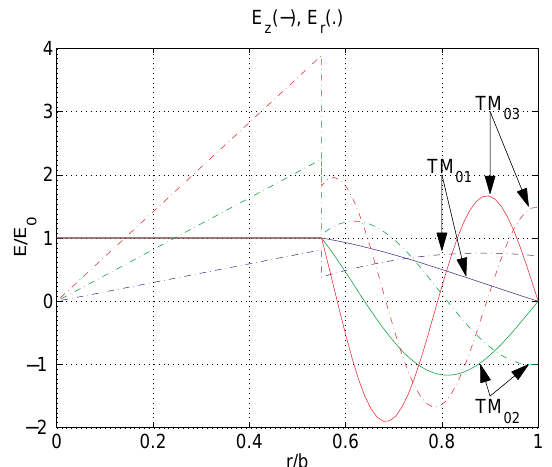
FIG. 2. (Color) Electric field distribution inside the DWA. Solid lines and dotted lines represent longitudinal and transverse elec- tric fields, respectively.